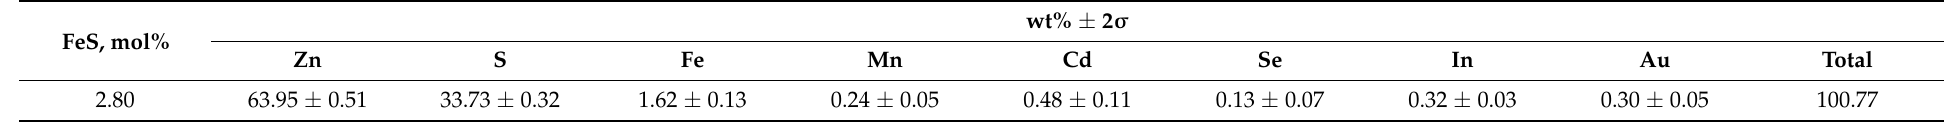
Table 26. Chemical composition of ZnS sample 1450 (EPMA) synthesised at 850 ◦ C using the gas transport method with I 2 as a transport agent.